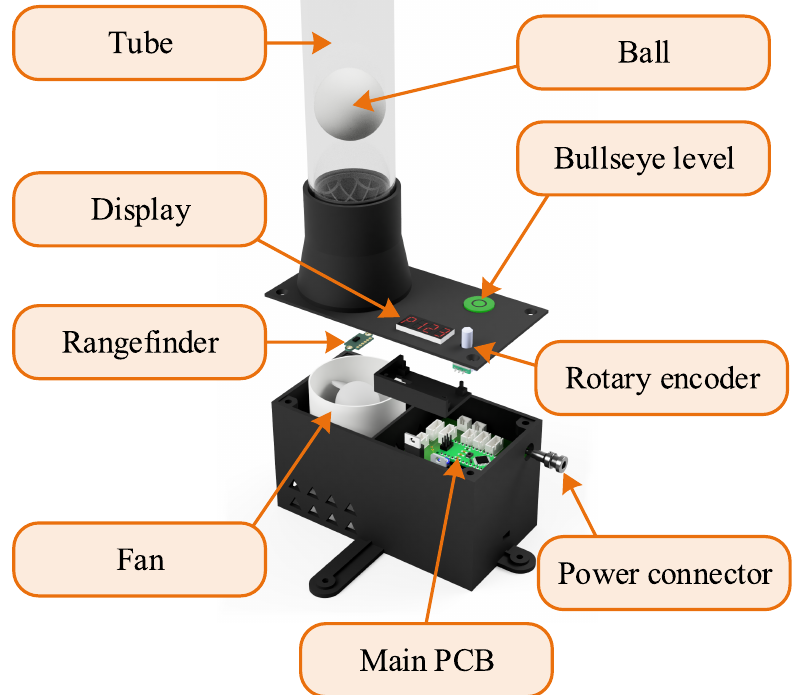
Figure 1. Component assembly of the Aerodynamic Ball Levitation Laboratory Plant.